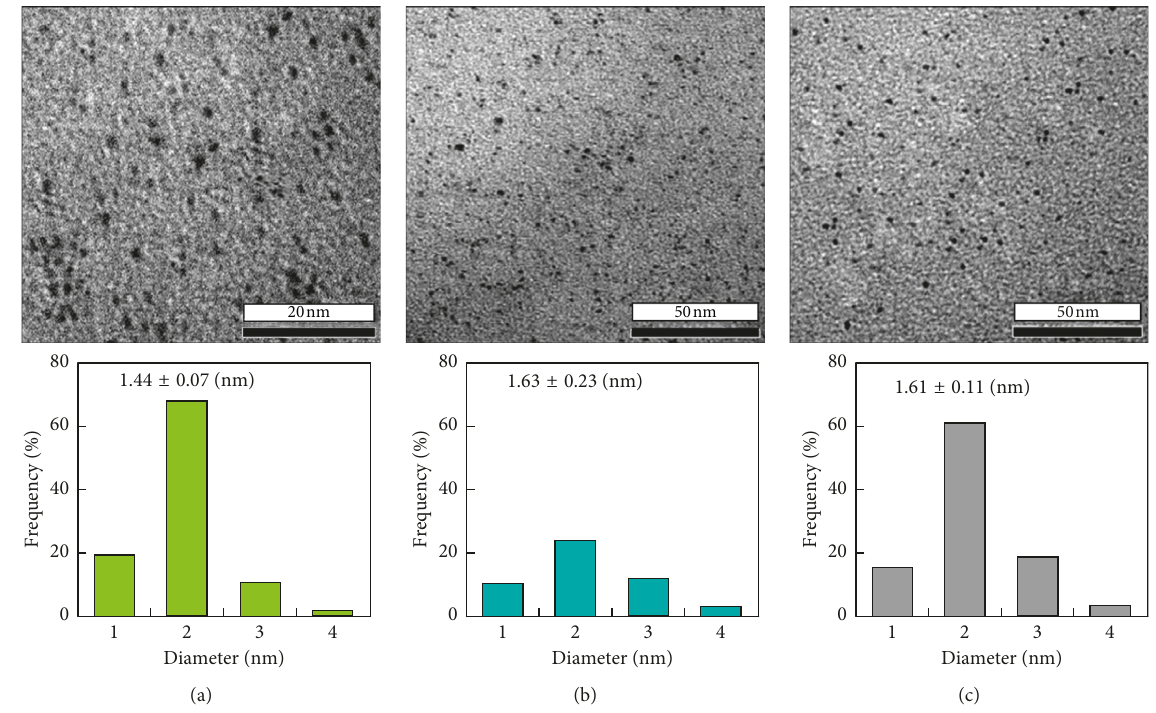
Figure 3: TEM images and size distribution of PtNPs from 1mM PtNPs in 0.5% CTS (a), 1.0% CTS (b), and 2.0% CTS